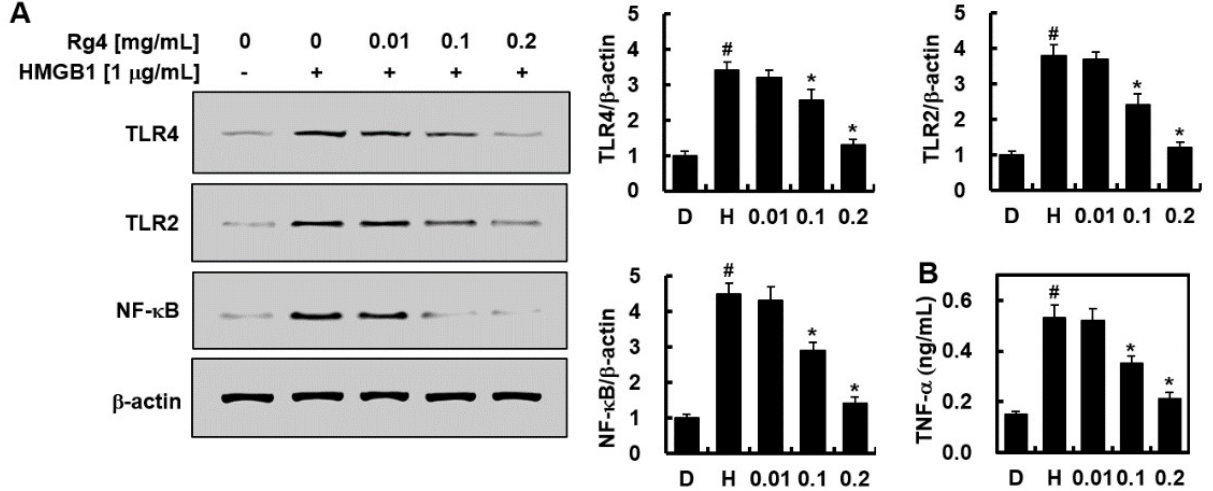
Figure 3. Inhibition of HMGB1-induced TLR/NF-κB expression by Rg4 in vitro. ( A ) HUVECs were activated with HMGB1 (1 μg/mL) treatment for 6 h, followed by treatment with various concentrations of Rg4 for another 6 h. Cell lysates were subjected to Western blot analysis to determine the protein levels of TLR2, TLR4, and NF-κB. Representative Western blots (left) and relative densito- metric quantification (right) of each gene. ( B ) Supernatants from ( A ) were used for TNF-α ELISA. All values are presented as the mean ± SD of three separate experiments. D = 0.5%, DMSO was the vehicle control and H = HMGB1. # p < 0.01 vs. DMSO or * p < 0.01 vs. HMGB1 group.